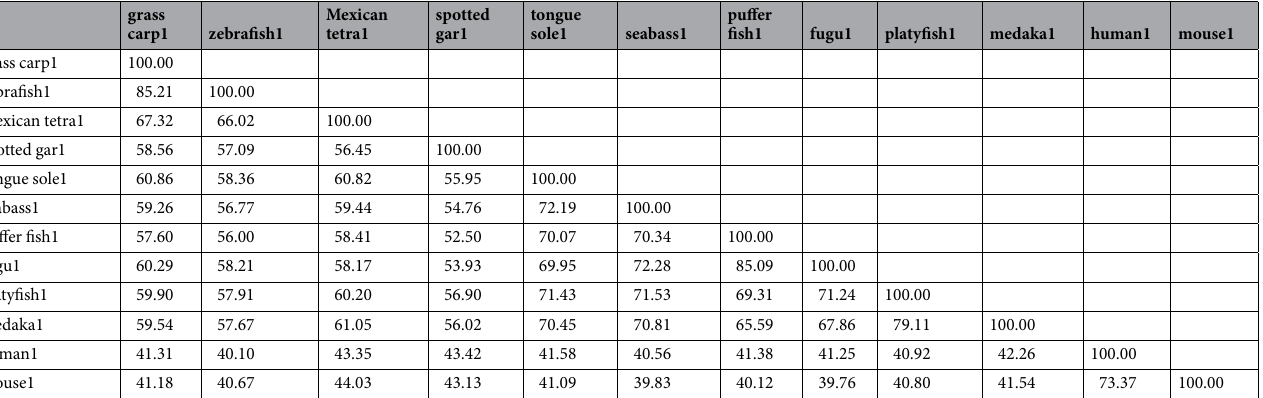
Table 1. Amino acid sequence identities of T1R1 compared with other fish and mammals. Amino acid sequences available in the EMBL/GenBank databases and food habit information of fish are shown in Table 3.